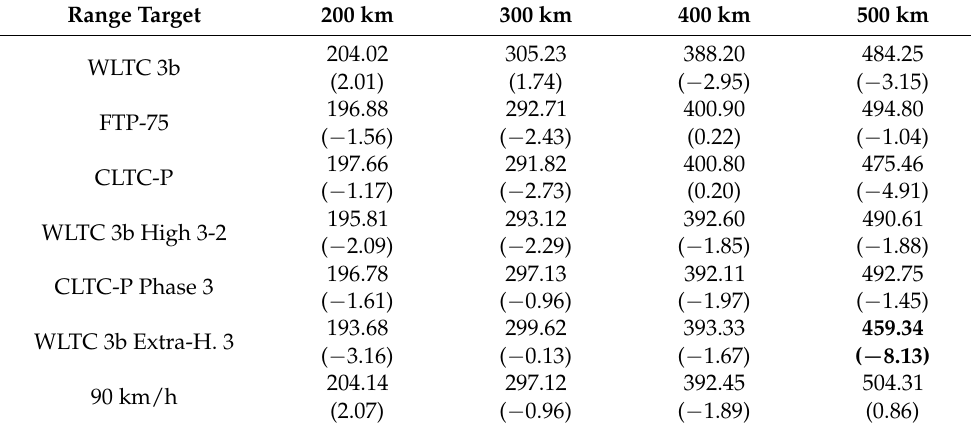
Table A1. Difference between range target and traveled range at 15% SOC. Bolded values indicate cases when the range target cannot be obtained. Vehicle mass is 1800 kg. The average percent difference (excluding data when range cannot be obtained) is − 1.00%, with a standard deviation of